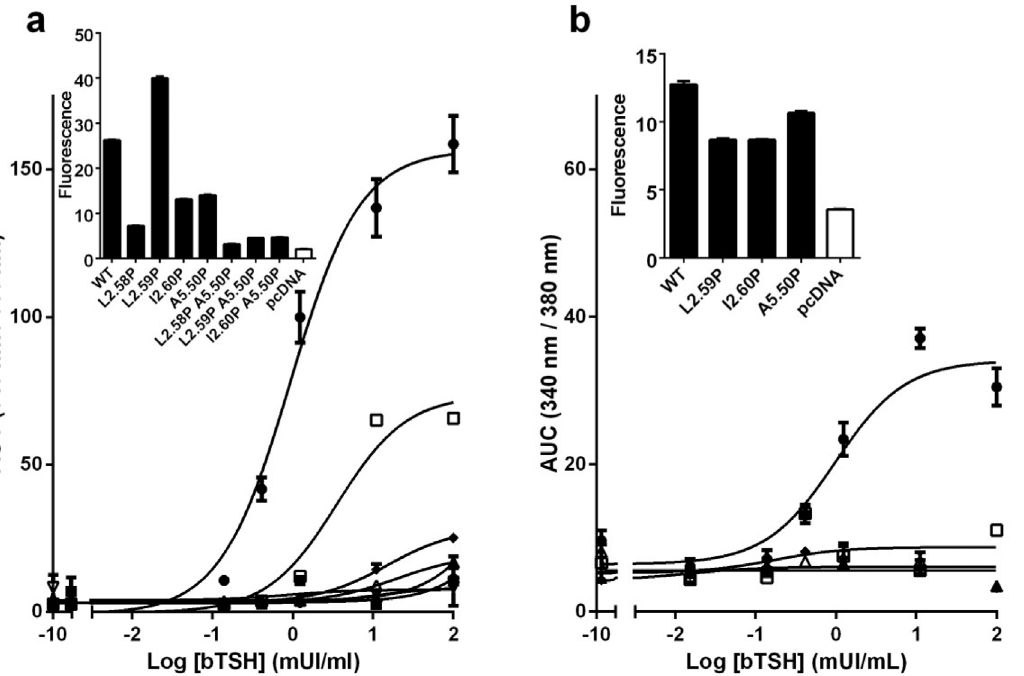
Fig 7. TSH induced Ca 2+ response of TSHR mutants. Typical dose-response curves of Ca 2+ accumulation induced by TSH on HEK-293 cells transfected with pcDNA3.1 plasmids encoding WT or mutated TSHR. In (a), the cells were transfected with the same amount of TSHR coding plasmids, yielding the membrane expression shown in insert. In (b), the cells were transfected with different amounts of TSHR coding plasmids to obtain similar levels of cell surface expression, shown in insert. The total amount of pcDNA3.1 plasmids was kept constant by addition of empty plasmids. Receptor symbols: closed circles, WT; closed down triangles, L2.58P; open squares, L2.59P; open triangles, I2.60P; closed diamonds, A5.50P; closed squares, L2.58PA5.50P; closed triangles, P2.59PA5.50P; open diamonds, I2.60PA5.50P.